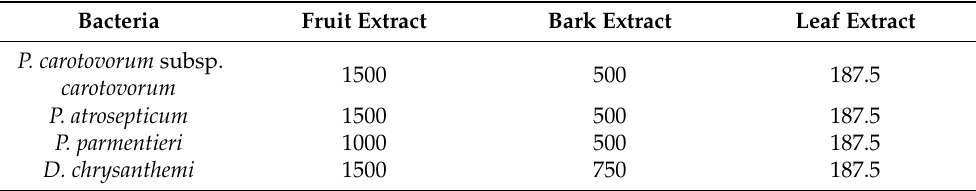
Table 2. Minimum inhibitory concentrations of Taxus baccata extracts against several soft rot Pecto- bacteriaceae (SRP) taxa, expressed in μg·mL −1 . Bacteria Fruit Extract Bark Extract Leaf Extract P. carotovorum subsp. carotovorum